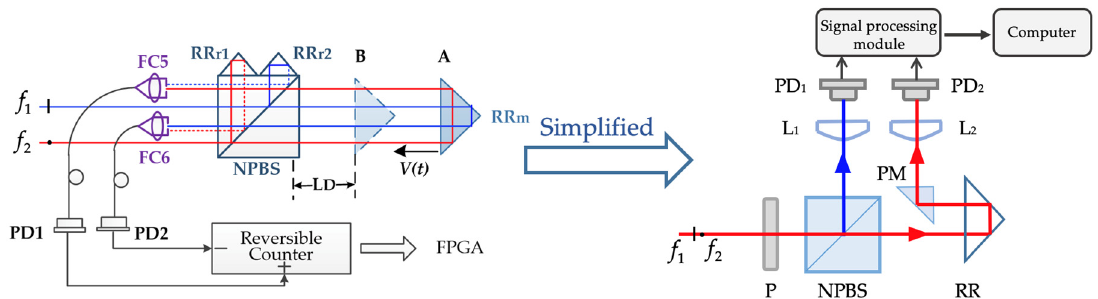
Figure 2. Scheme for the simplified optical path structure. P, polarizer; NPBS, non-polarizing beam splitter; RR, retro reflectors; PM, prism mirror; L, lens; PD, photodetector; M, mirror.